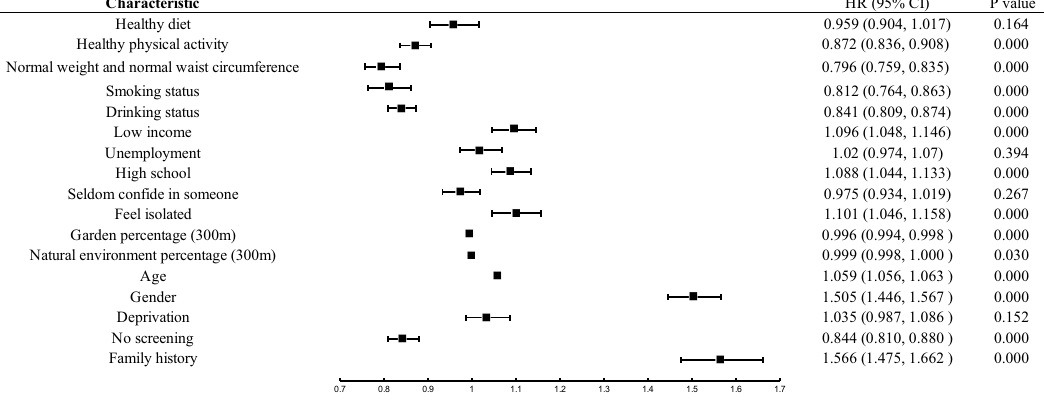
Figure 3. Effects of exposome variables on the risk of CRC in the UKB cohort.